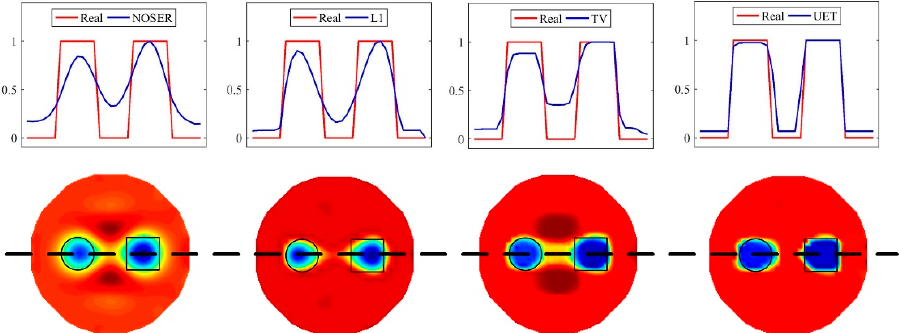
Figure 10. Contour of the reconstructed images along the center horizontal line.